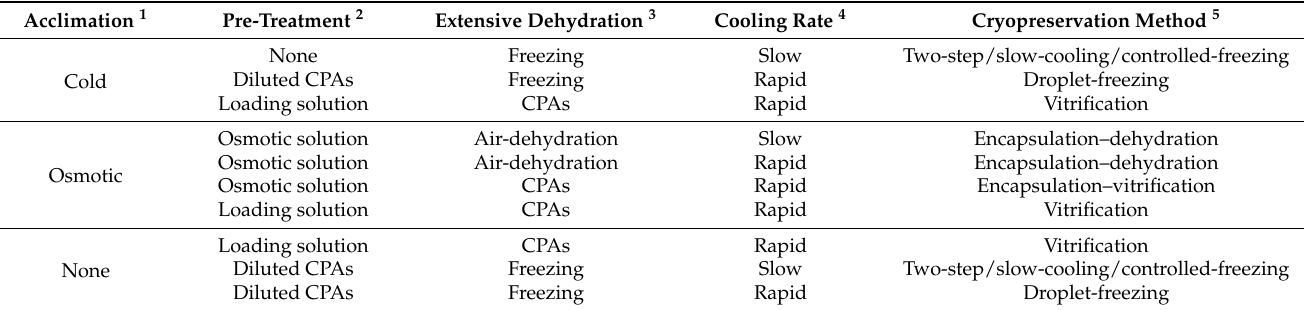
Table 1. Characteristics of cryopreservation methods with respect to acclimation and